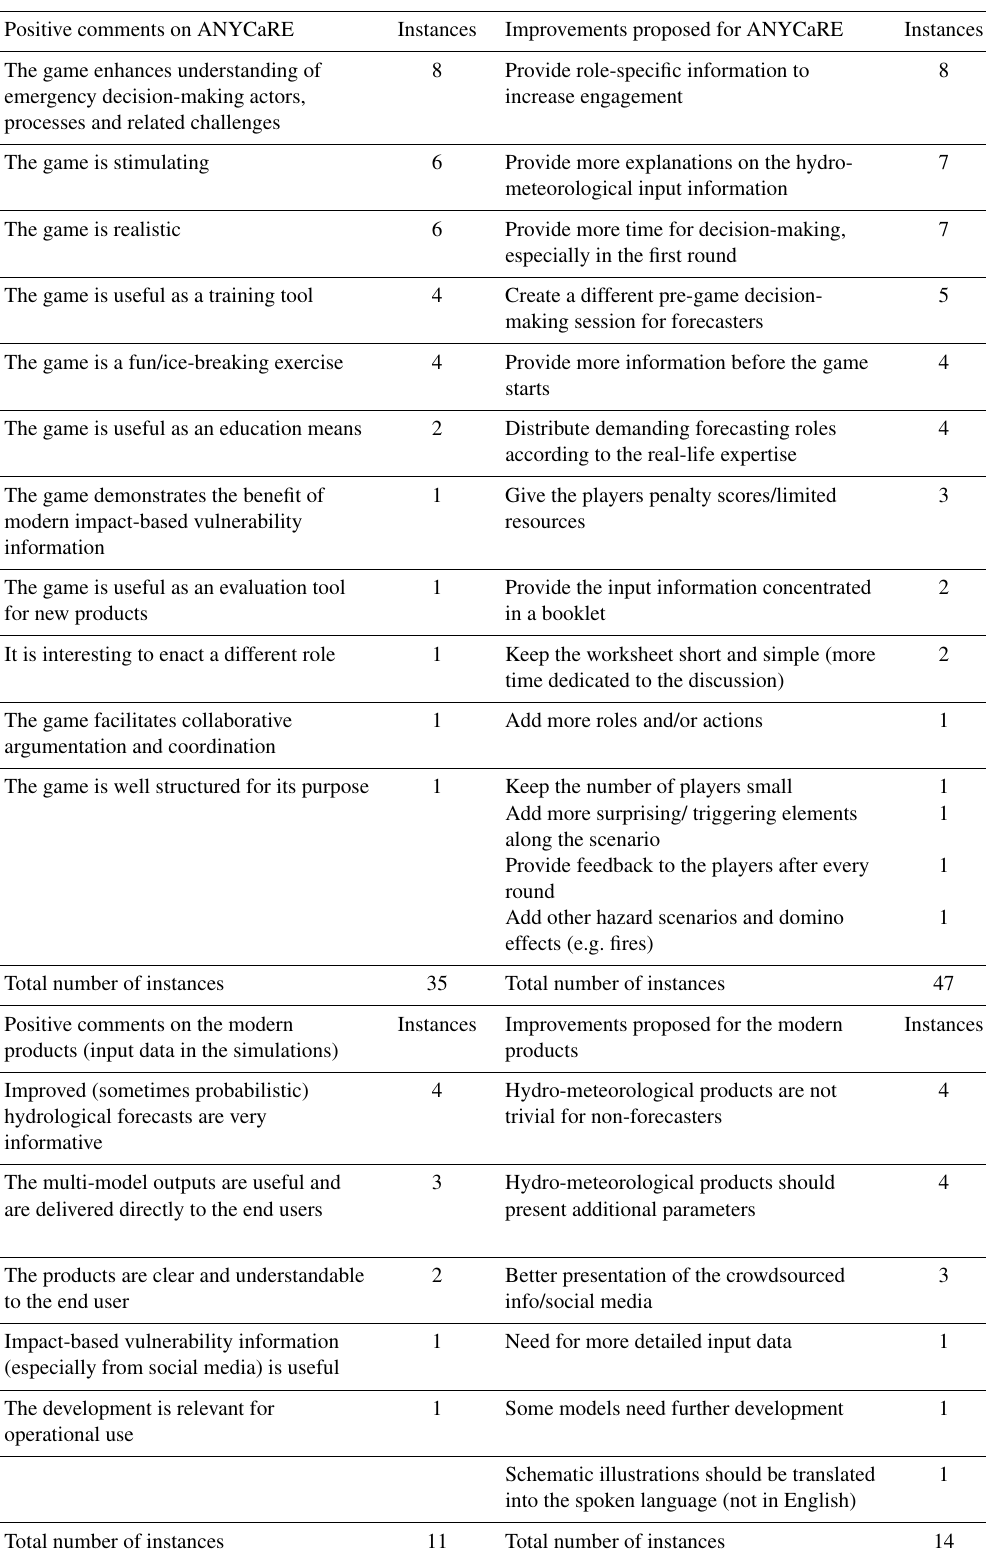
Table 4. Themes of the players’ comments recorded in the post-it notes in the debriefing phase of the four ANYCaRE experiments. Every comment was placed in one theme. Post-it notes with more than one thematic annotation were assigned to more themes to match comments to